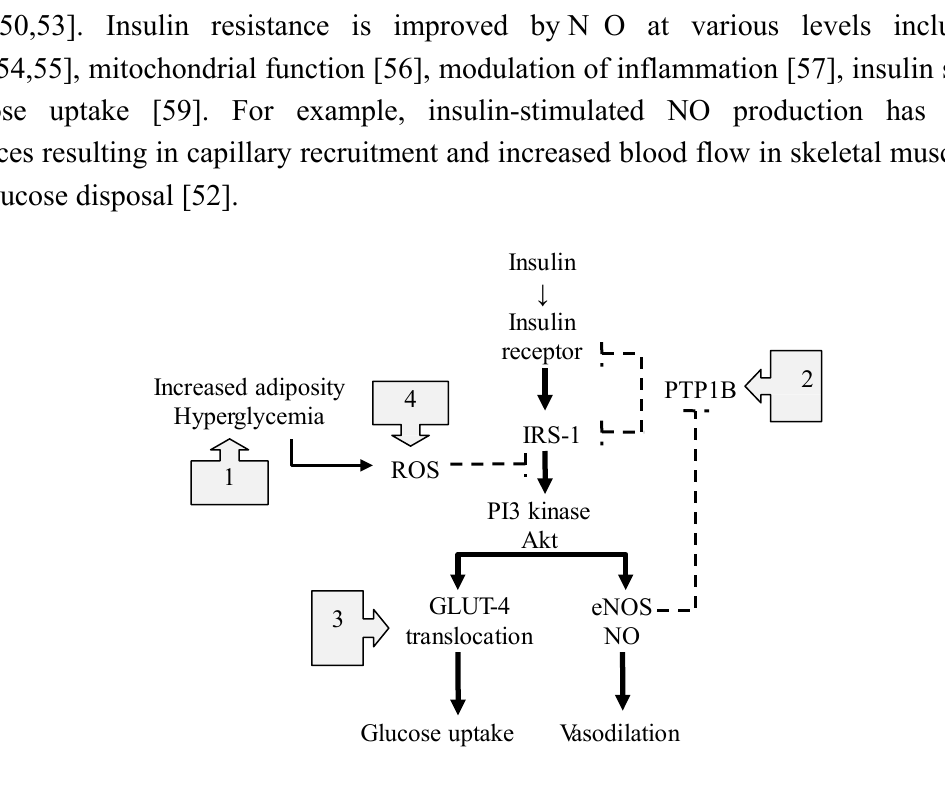
Figure 4. The NO-mediated actions on insulin signaling pathway. The boxes with arrows indicate the sites of NO-mediated actions against insulin resistance. Dotted lines represent inhibition, and solid lines represent stimulation. ( 1 ) NO suppresses TLR4-mediated inflammation and ROS production; ( 2 ) NO enhances the effects of insulin through the S- nitrosylation-mediated inhibition of phosphatase activity of PTPB1; ( 3 ) NO-dependent nitrosylation of GLUT4 facilitates glucose uptake; ( 4 ) NO inhibits mitochondrial ROS production through S- nitrosylation of the